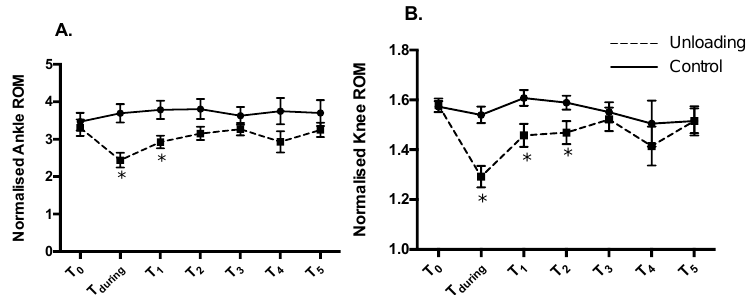
Figure 6. Group means ( ± SEM) of normalized range of motion of ( A ) ankle and ( B ) knee joint across different epochs during control and unloading conditions. * Significant difference ( p < 0.05) relative to T 0 of the corresponding condition.